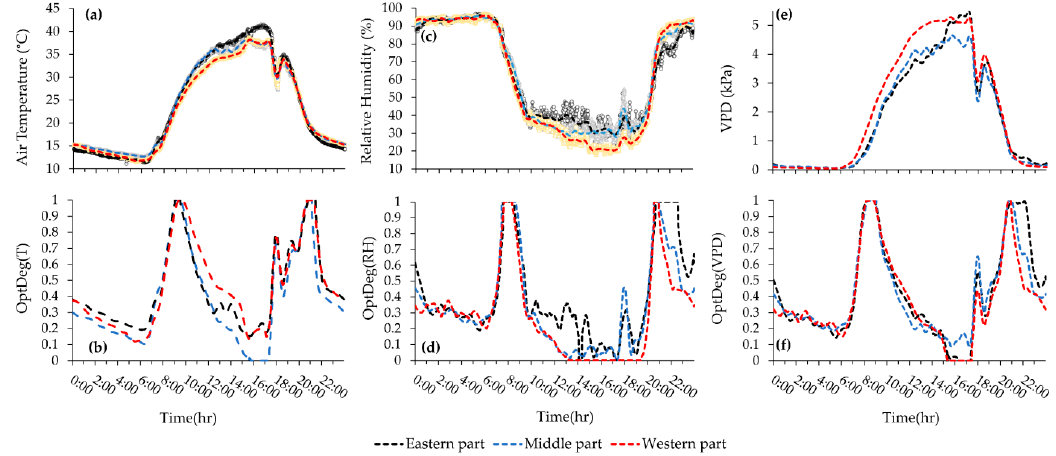
Figure 10. Hourly average variations of microclimate parameters and OptDeg at 10 June 2018. ( a ) air temperature; ( b ) OptDeg(T); ( c ) relative humidity; ( d ) OptDeg(RH); ( e ) vapor pressure deficit and ( f ) OptDeg(VPD).